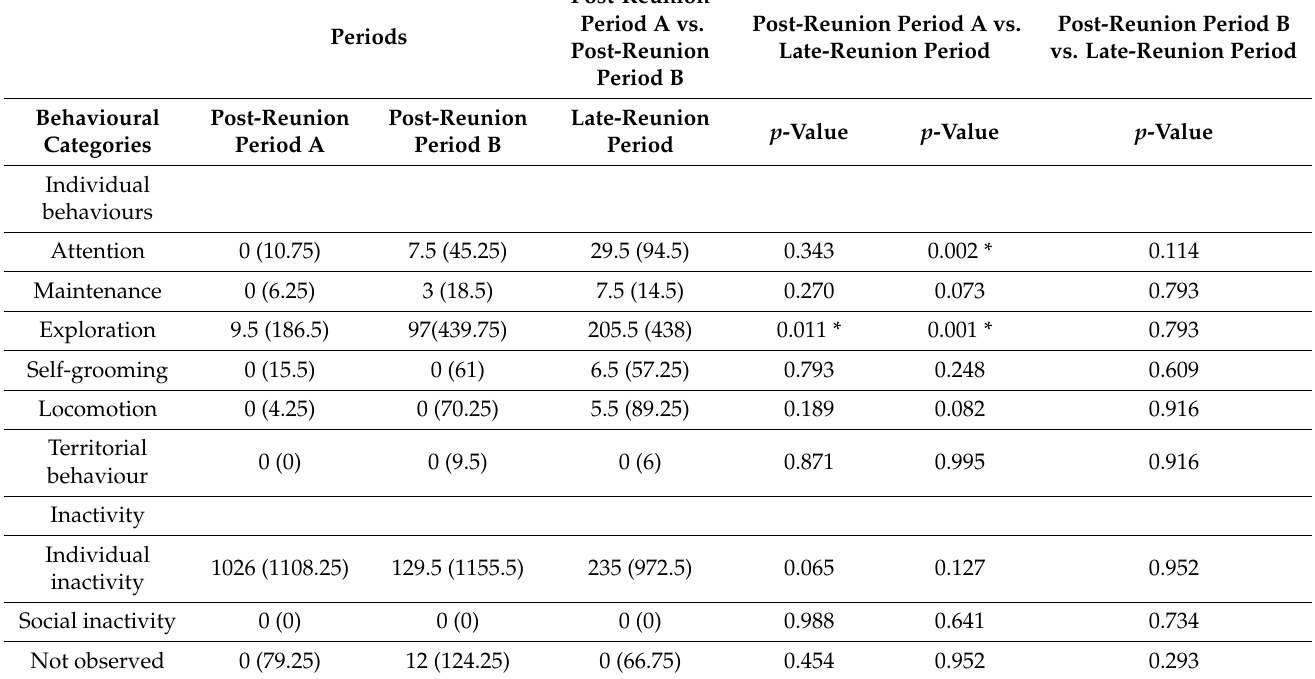
Table 4. Behavioural categories performed by wildcats across the periods. For each behavioural category, the table reports the median (IQR) duration in seconds. Moreover, p values of the Nemenyi test from the comparison between the periods are reported. Asterisks indicate a significant difference ( p < 0.05). Post-Reunion Post-Reunion Period A vs. Post-Reunion Period B Period A vs. Periods Late-Reunion Period vs. Late-Reunion Post-Reunion Period B